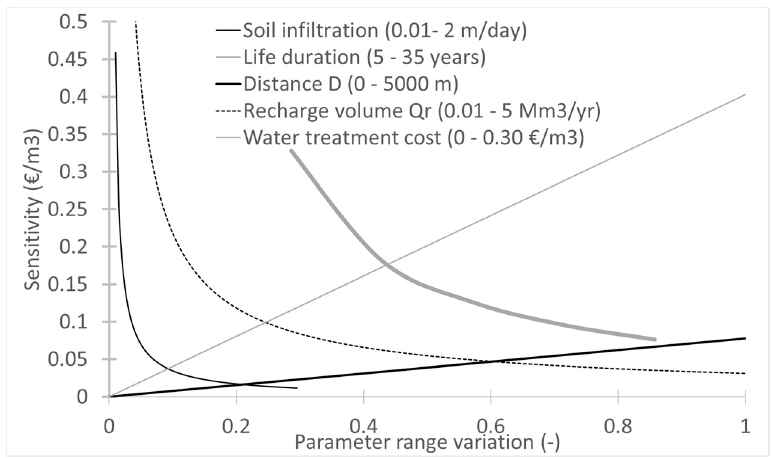
Figure6. Levelisedcostsensitivityanalysistowatertreatmentcost, rechargewatervolume, MARsystem Figure 6. Levelised cost sensitivity analysis to water treatment cost, recharge water volume, MAR life duration, and distance between the abstraction and recharge system life duration, and distance between the abstraction and recharge locations.